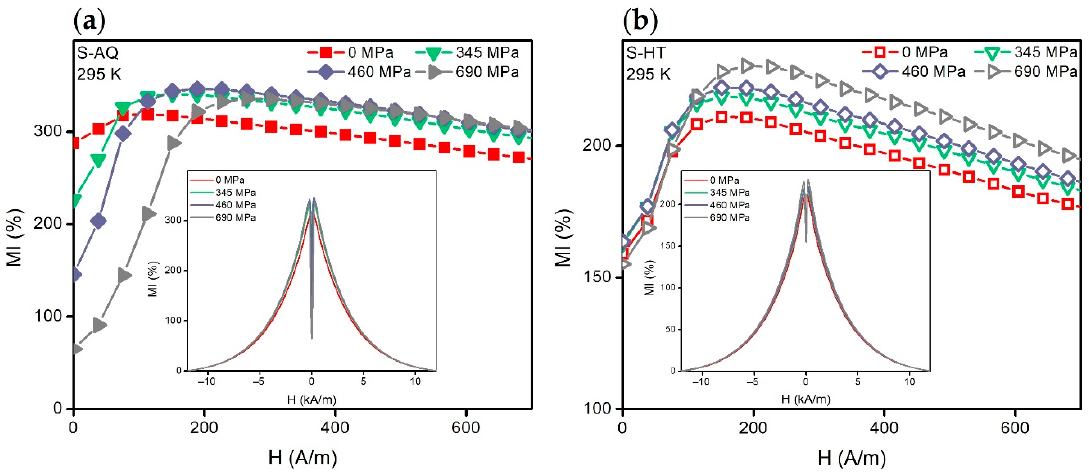
Figure 5. Magnetoimpedance dependencies MI ( H ) of the S-AQ ( a ) and the S-HT ( b ) samples. Dependencies were obtained at the AC frequency of 10 MHz at the following tensile stresses: 0, 345, 460, and 690 MPa. The insets show the same MI ( H ) dependencies in the H range of − 12 to 12 kA / m. The MI value of the ribbons becomes smaller after the heat treatment (Figure 4, empty symbols).